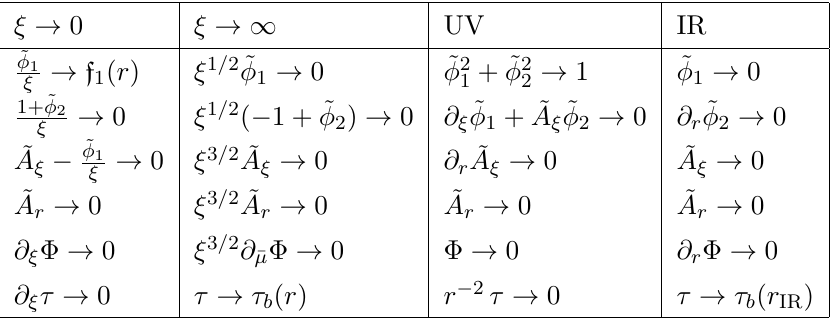
Table 1 . Gauge invariant boundary conditions for the fields of the baryon solution